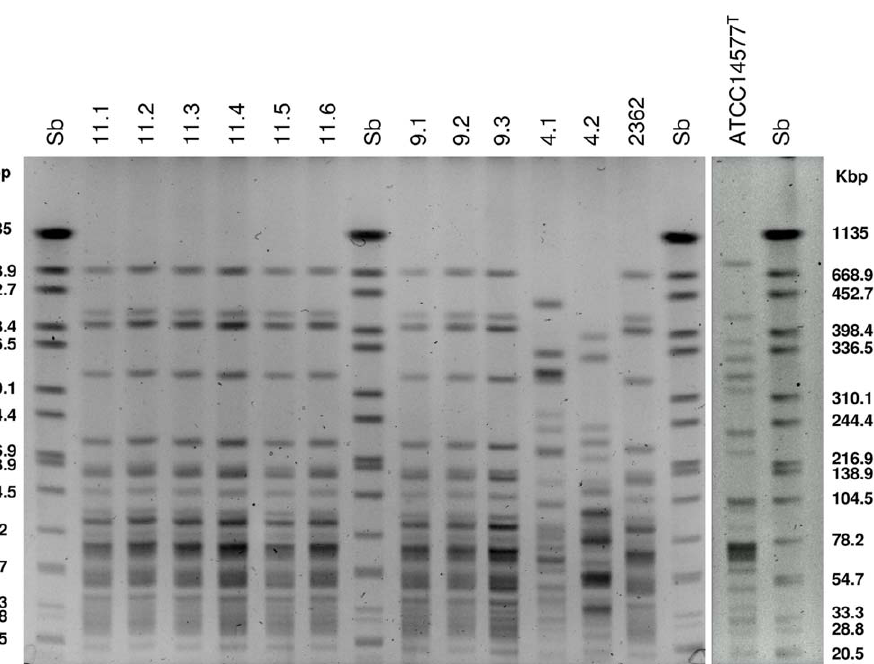
Figure 3. PFGE patterns of Sma I digested genomic DNA of the 11 Lysinibacillus isolates and references (strains 2362 and the ATCC14577 T ). Sb: Salmonella serotype Braenderup H9812 restricted with Xba I.